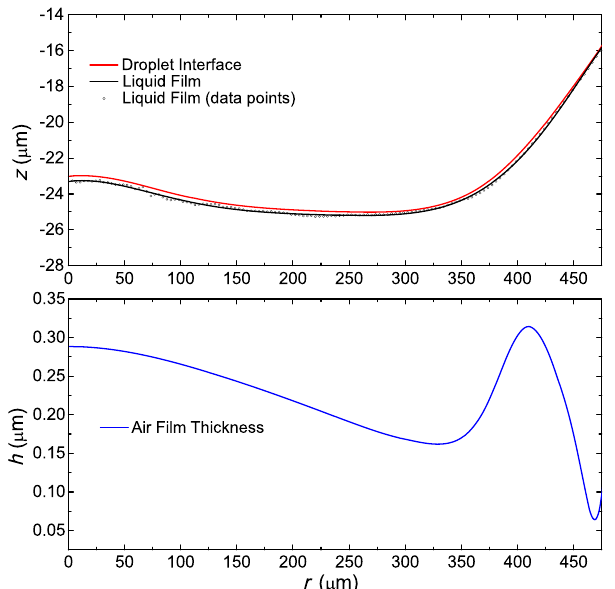
FIG. 11. Upper panel: Plotting the liquid film interface (the black curve and symbols) and the droplet interface (the red curve) together in one plot. The difference in between is the air gap. Clearly the air gap thickness is much smaller than the liquid film deformation. Also note that the black curve is measured by confocal profilometry and the red curve is obtained by dual- wavelength interferometry: due to equipment limitations, they can be measured only in two separate experiments with identical conditions instead of in one single experiment. The lower panel magnifies this air gap in a zoomed-in scale.